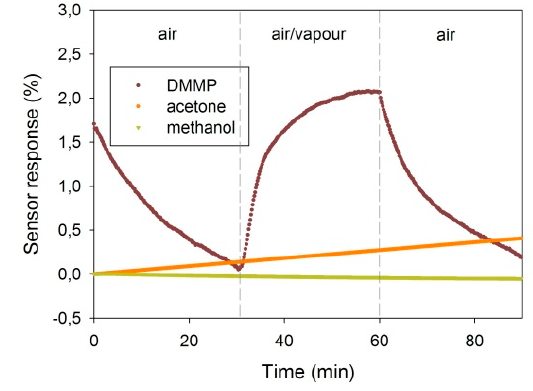
Figure 3. Sensor response to 6 ppm of DMMP, acetone and methanol